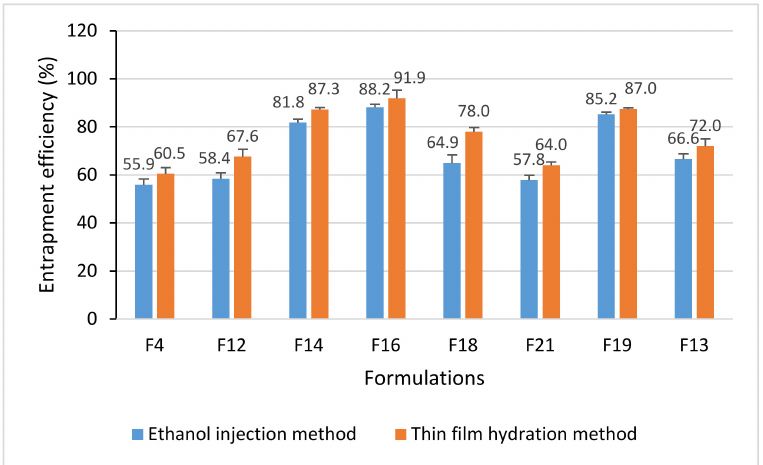
Figure 8. Entrapment efficiency (EE) of the berberine (BBR)-loaded liposomes generated by ethanol- injection (FJ) and thin-film hydration (FH) methods ( n = 3, mean ± SD). Error bars show the standard deviation between three repeat